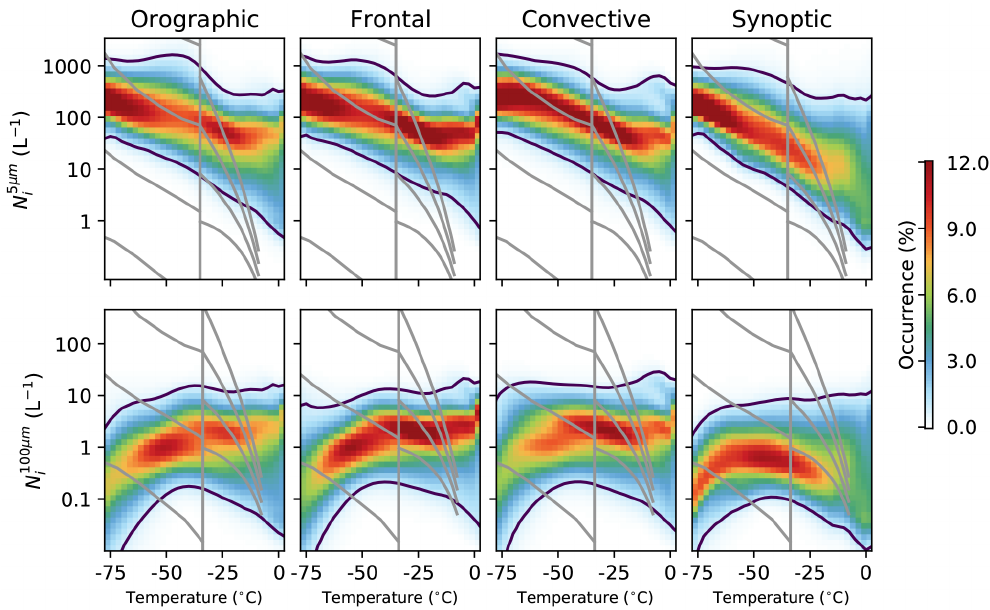
Figure 4. As in Fig. 2, but using the N i from throughout the cloud, rather than just the cloud top. The temperature scale is the temperature of the N i retrieval, rather than that of the cloud